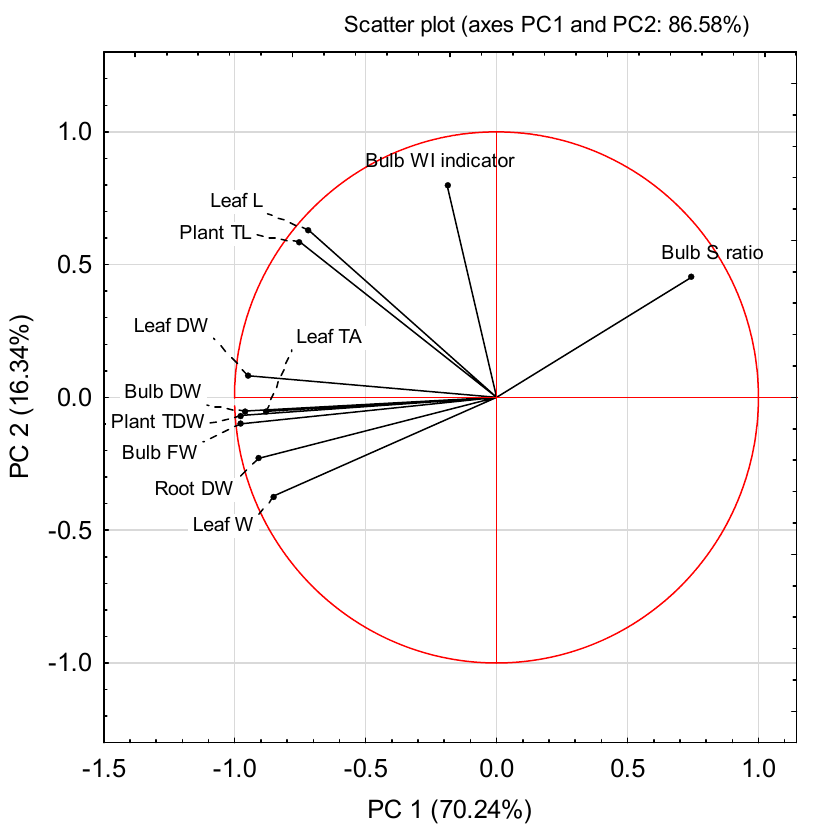
Figure 13. Principal components analysis outputs illustrated on a plot showing projected in the plane the position of variables as determined by the first two principal axes (explaining 86.58% of variance).